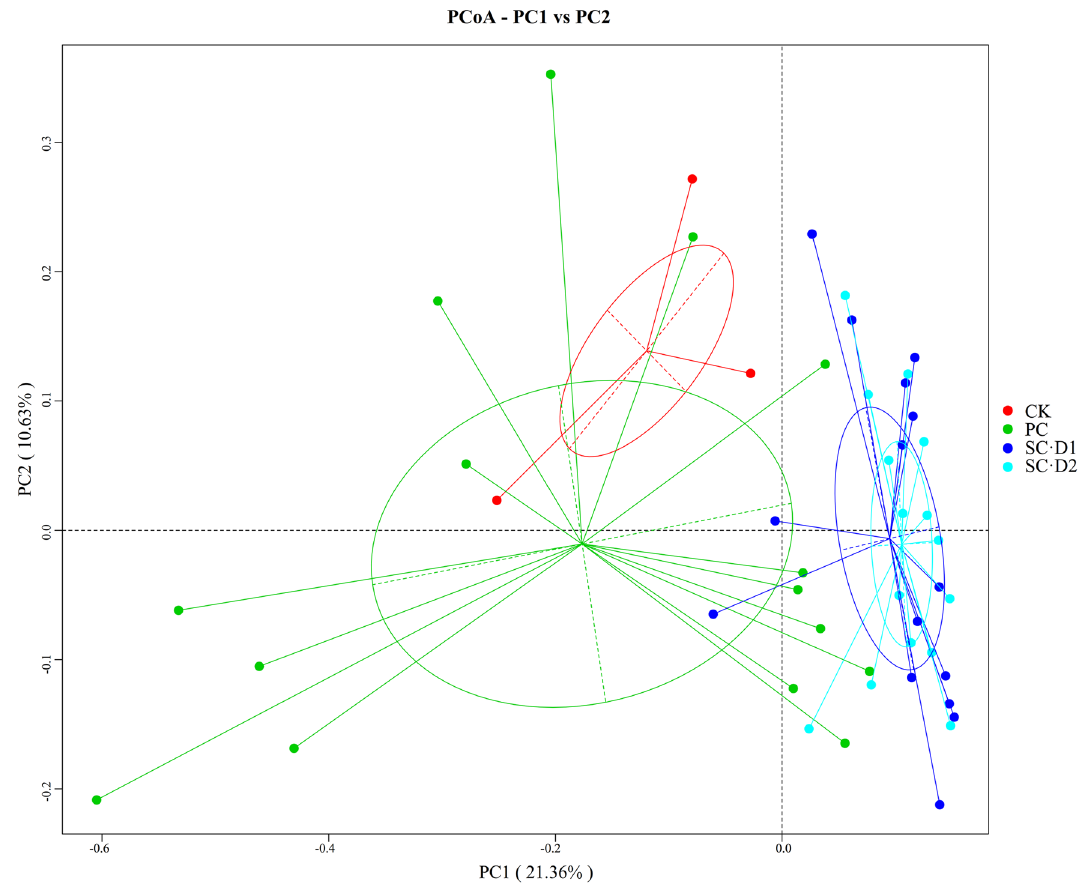
Figure 3. Soil bacterial community structure as described via PCoA